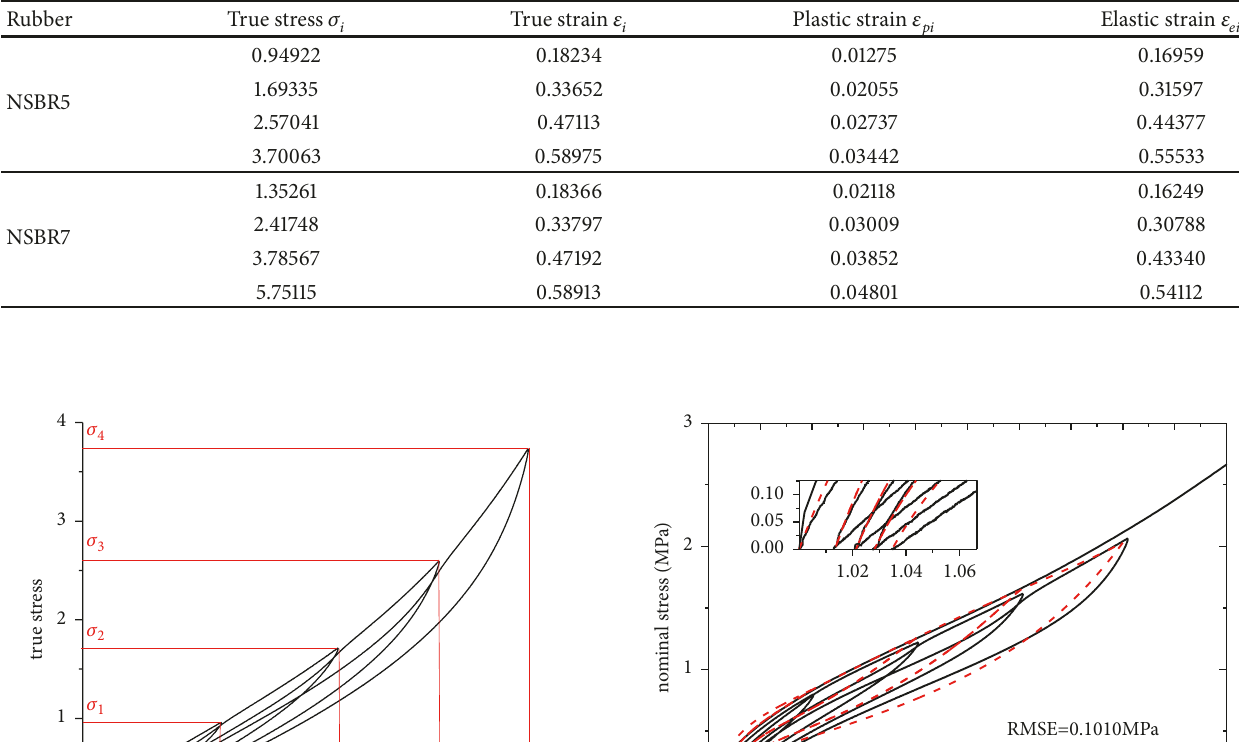
Table 3: Plasticity data obtained from the Mullins effect tests for NSBR5 and NSBR7.